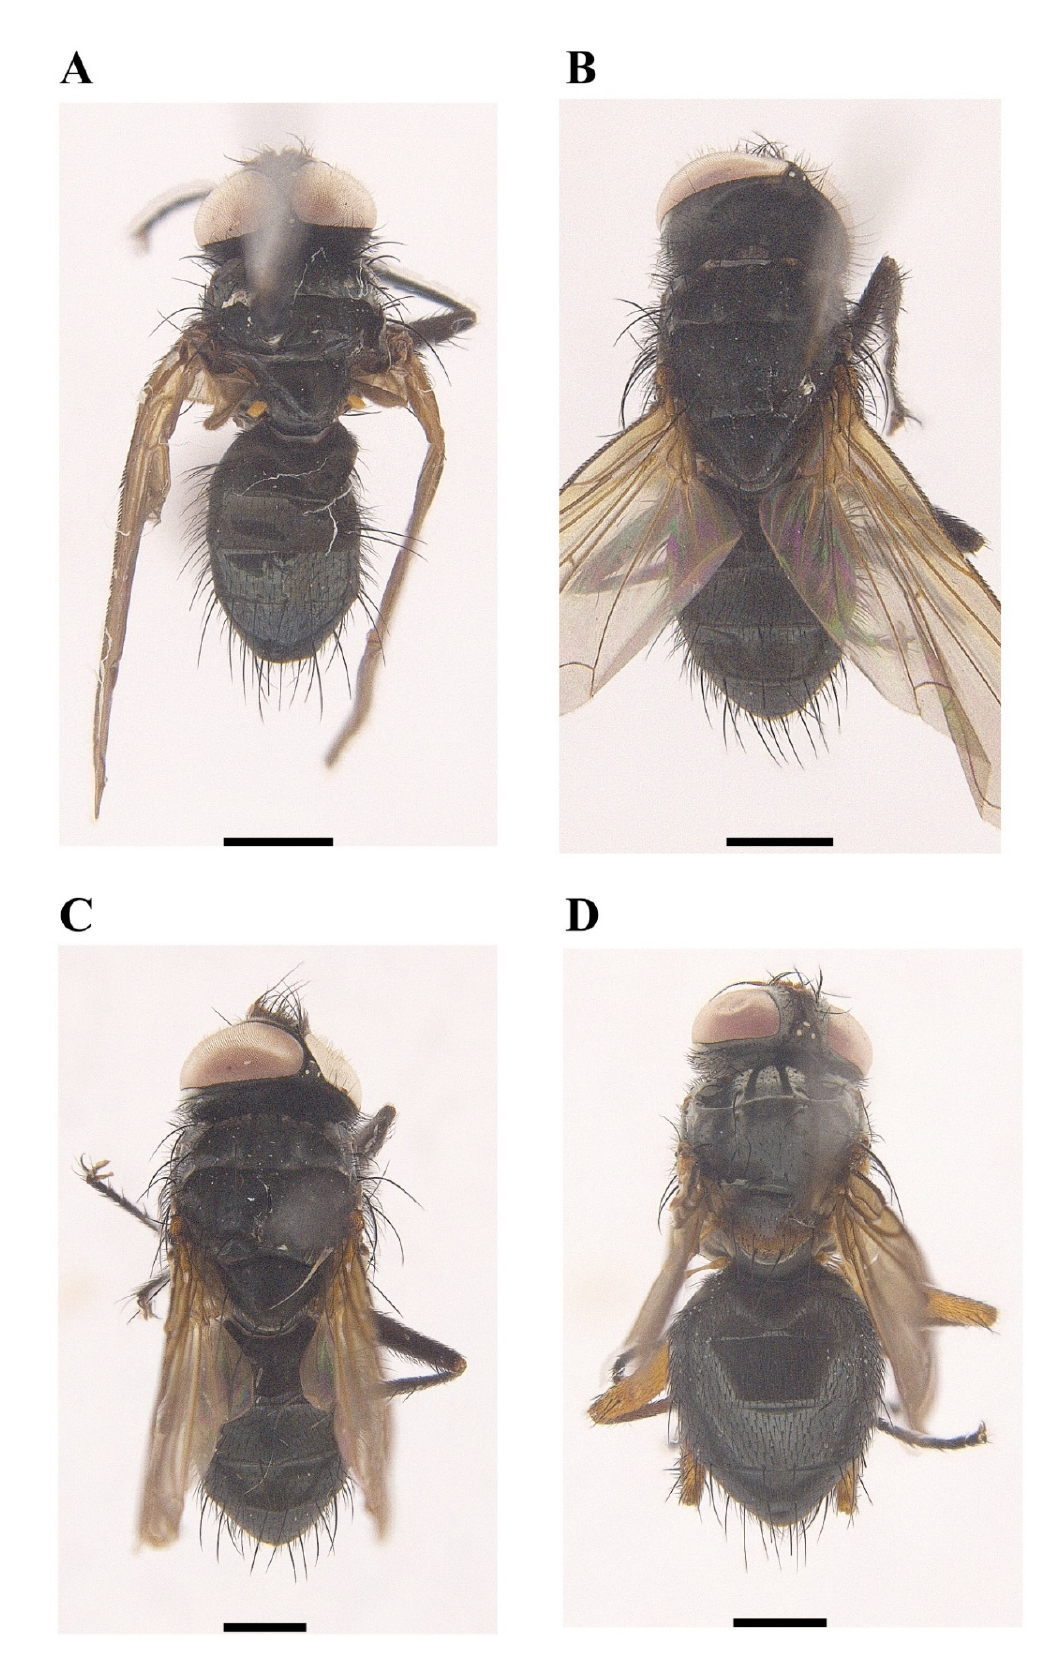
Figure 3. Dorsal view of Macquartia spp., male habitus. ( A ) M. brunneisquama sp. nov. ( B ) M. chinensis sp. nov. ( C ) M. flavipedicel sp. nov. ( D ) M. flavifemorata sp. nov. Scale bar = 1 mm.